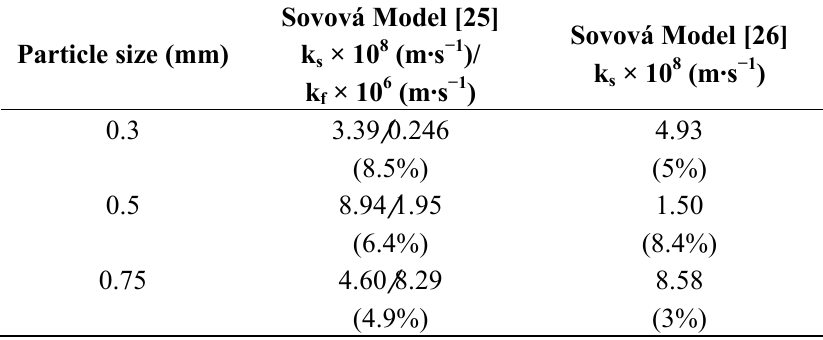
Table 6. Mass transfer coefficients for pennyroyal volatile oil extraction considering